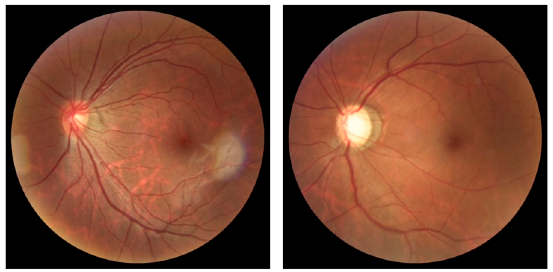
Figure 3. The images T0002.jpg ( left ) with normal excavation and T0010.jpg ( right ) with enlarged excavation were obtained from the test group at 25% of the original size.